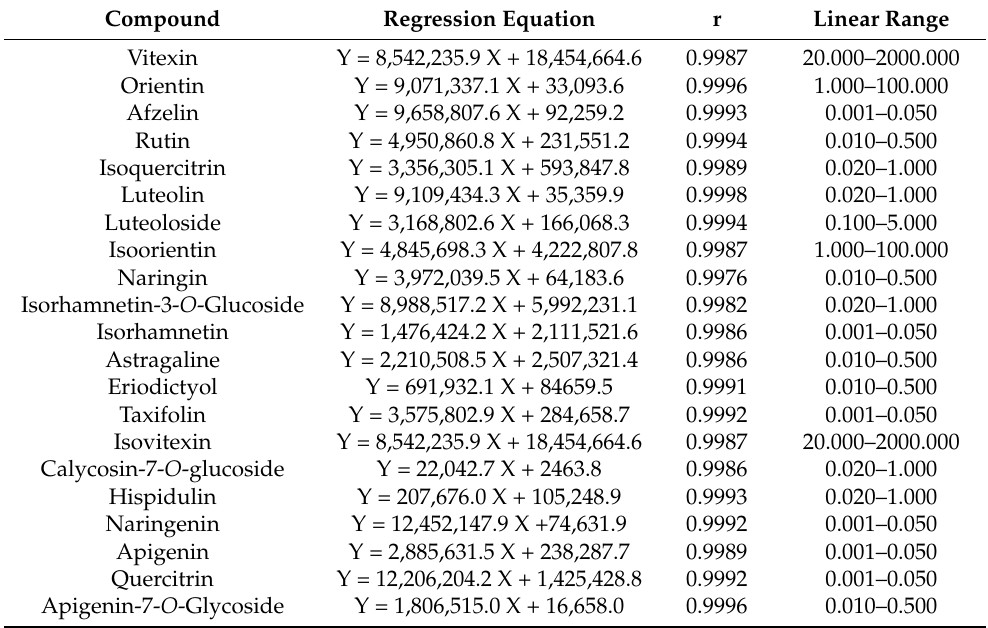
Table 2. Linear relationship investigation